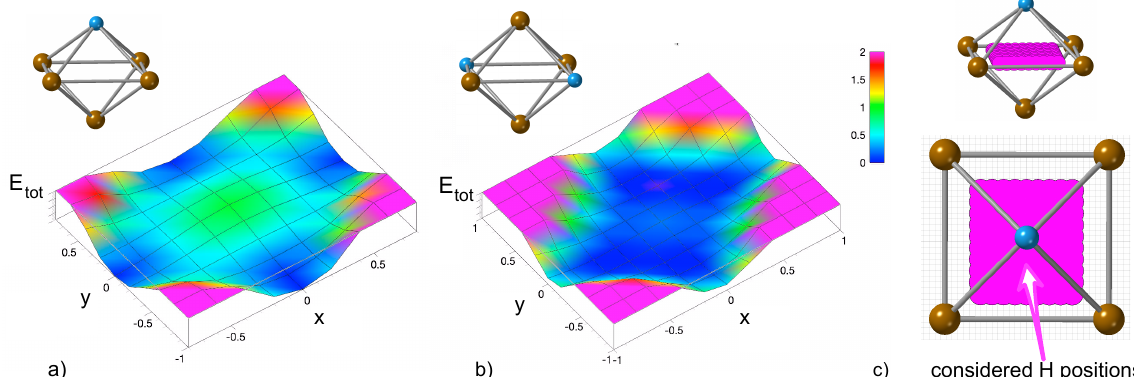
Figure 5. The energy surface corresponding to different locations of the H atom within a static lattice (modeled by 16-atom supercell) with the H atom inside an octahedron with only one Al atom ( a ) and within an octahedron with two Al atoms ( b ). The computed H positions are schematically visualized in part ( c ). The color-coded changes in the total energy are in eV. The x and y axes represent the shifts in the cartesian coordinates (Å) from the geometrically ideal octahedral site that is located in the origin